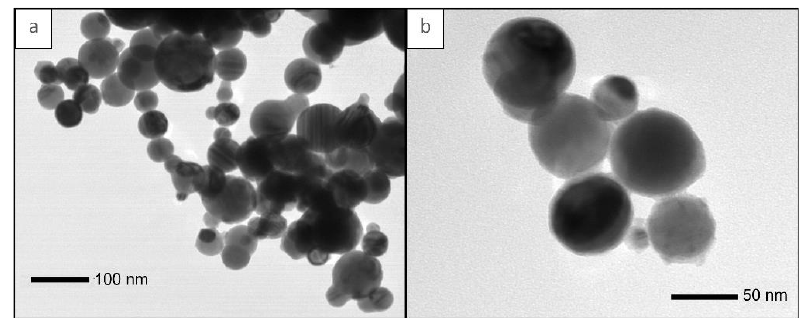
Figure 2. Transmission electron microscopy (TEM) of pure Py-NP. ( a ) Magnification 50k× and ( b ) Magnification 120k×.